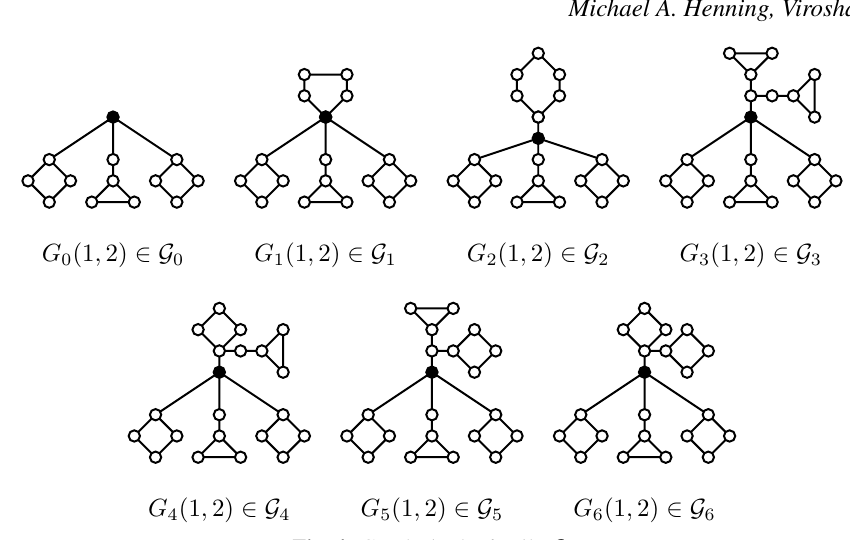
Fig. 4: Graphs in the family G .